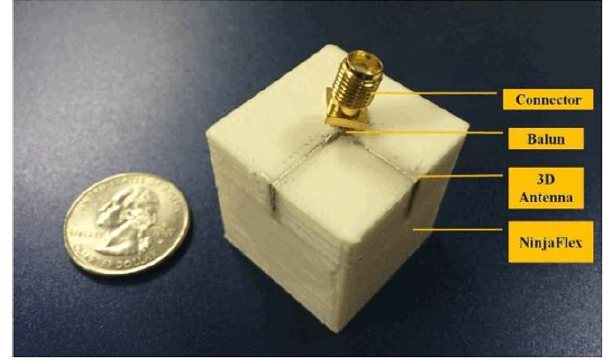
Figure 11. Ready-to-test 3D-printed strain sensor [18].